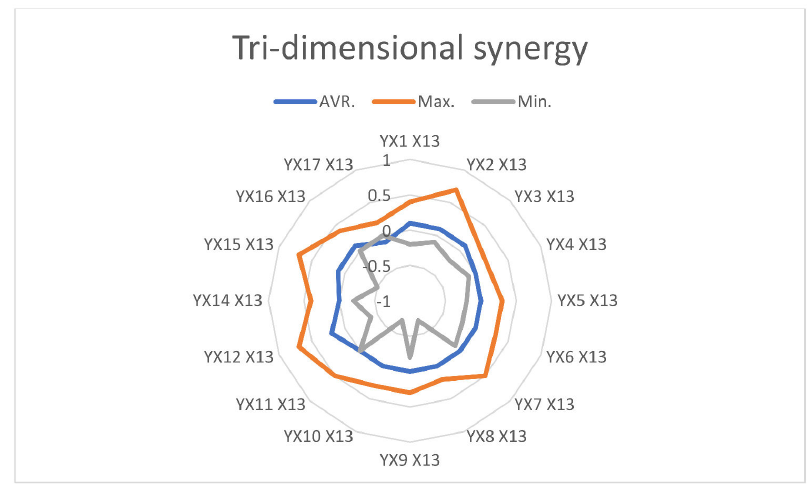
Figure 6. Tri-dimensional synergies in rapport with Training electric industry (X 13 ). Source: Authors’ representation.